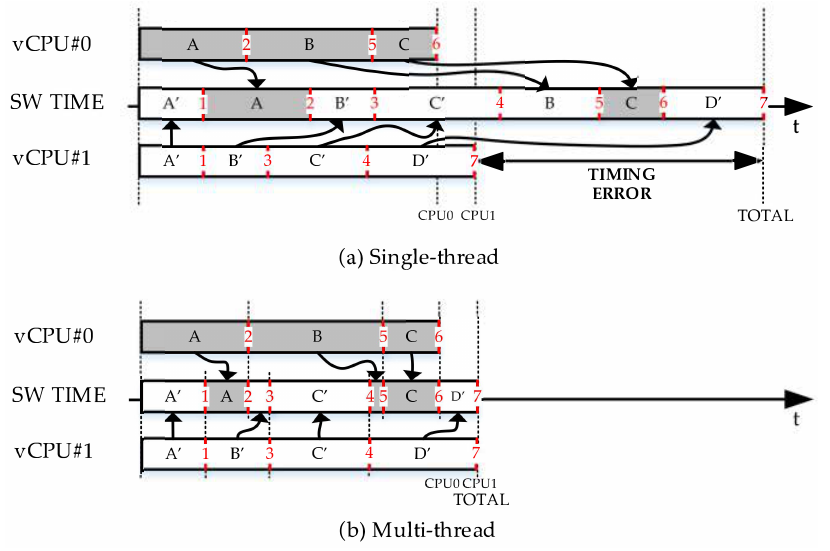
Figure 4. Comparison between timing flows for two vCPUs: ( a ) single-thread mode; ( b ) multi- thread